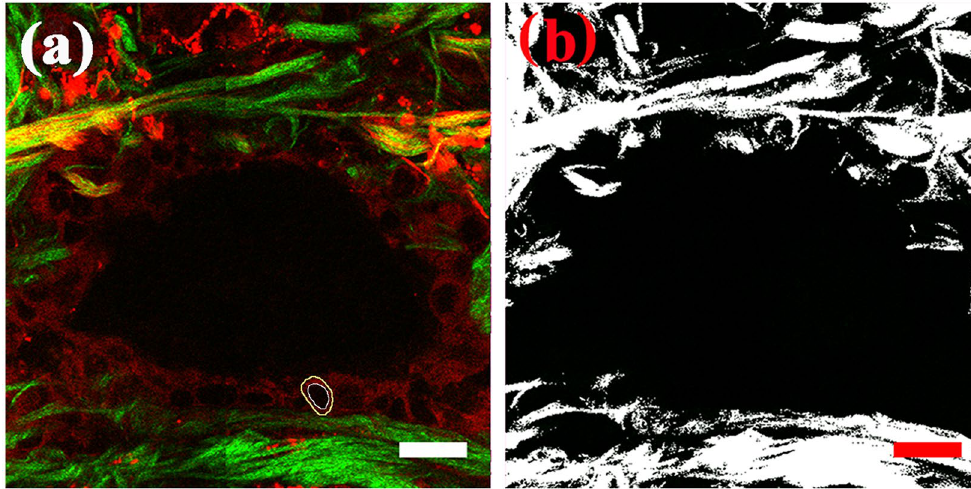
Figure 9. ( a ) Random area of MPM image; ( b ) The corresponding binary image. Scale: 20 μ m. White circle: nuclear boundary; yellow circle: cellular